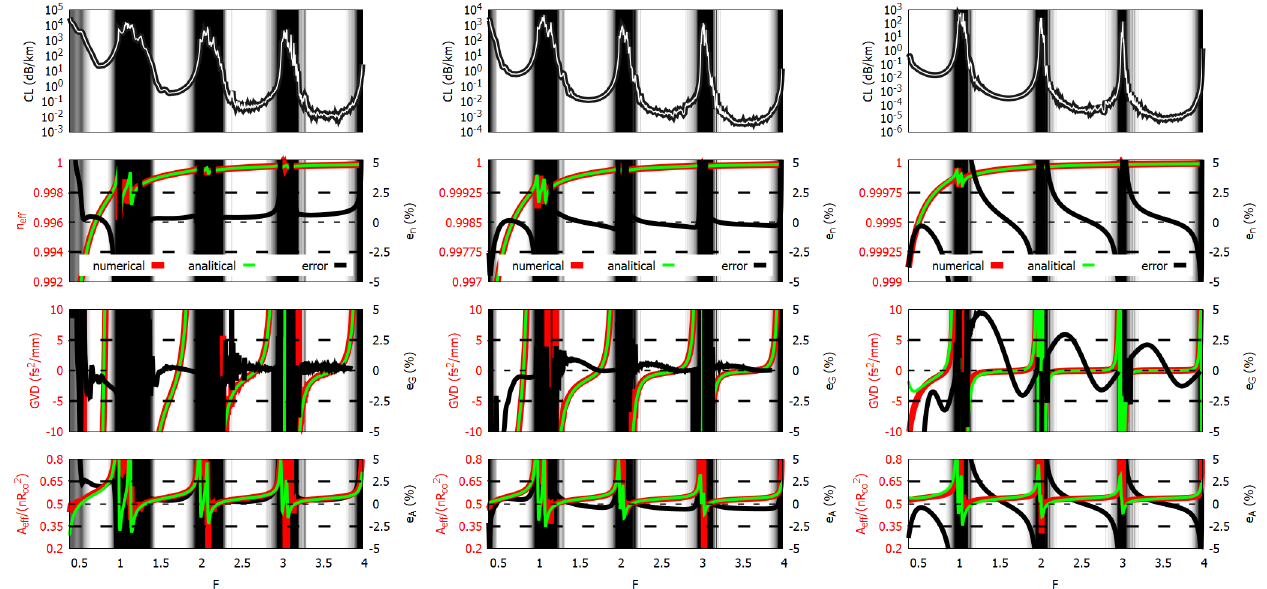
Figure 5. Confinement loss ( top row ), effective index ( top-central row ), group velocity dispersion ( bottom-central row ), and effective area ( bottom row ) of fibers F#2 ( left ), F#3 ( central ), and F#4 ( right ). Dark areas correspond to high-loss regions. For effective index, group velocity dispersion, and effective area, solid green, red, and black curves show numerical and analytical result, and relative error,